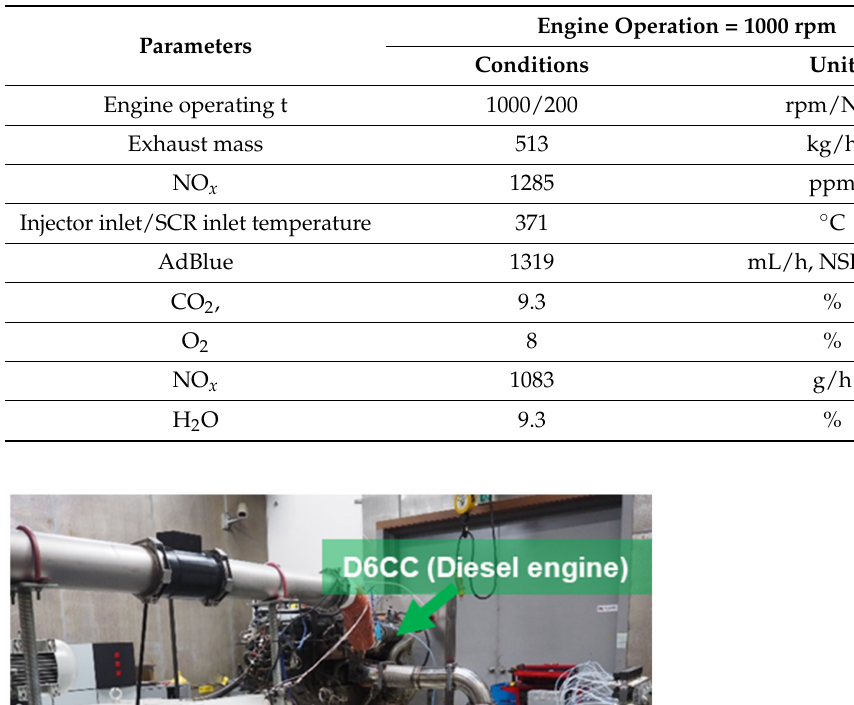
Table 12. Testing Parameters adapted from Khristamto et al. [39,122].